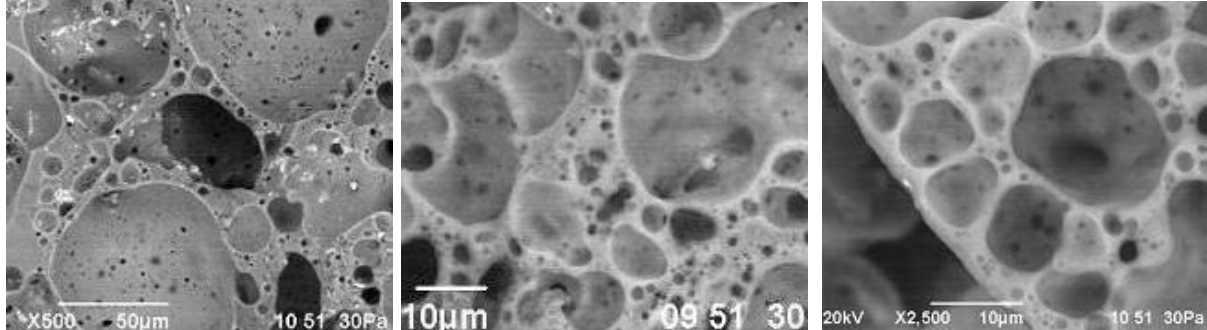
Figure 13. The structure of the fired granules: ( a ) at a temperature of 250 °C; ( b ) at a temperature of 550 °C; ( c ) at a temperature of 750 °C (granule surface); ( d ) composition of CB11, firing temperature 725 °C; ( e ) composition of CB21, firing temperature 775 °C; ( f ) composition of CB31, firing temperature 750 °C.